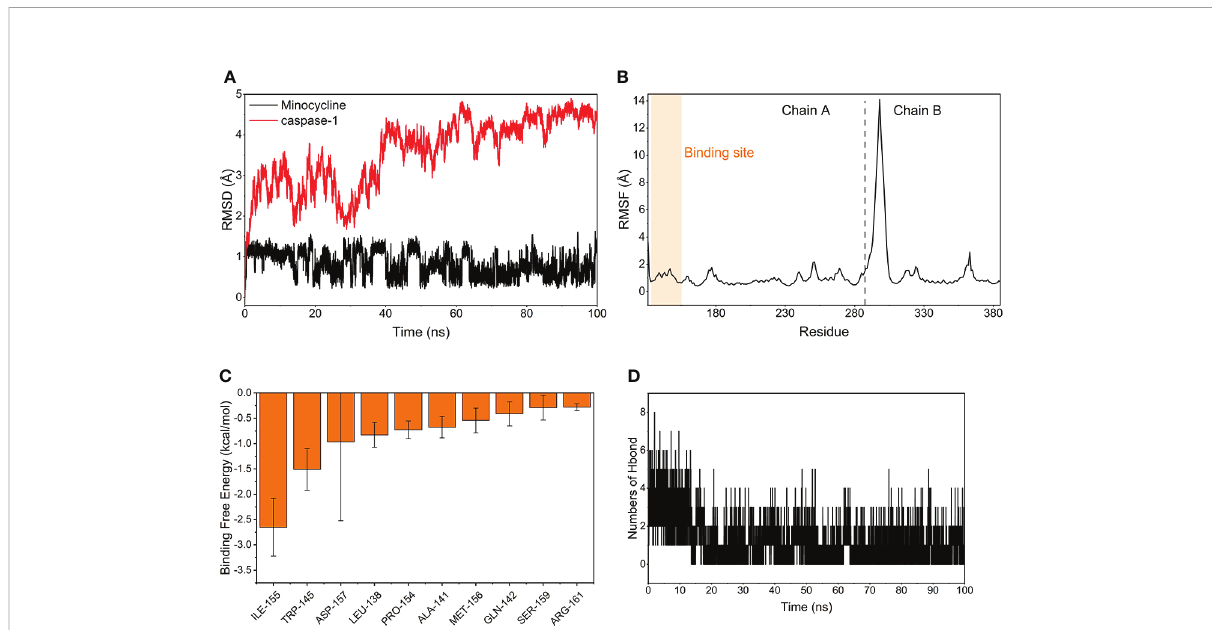
FIGURE 15 Molecular Dynamics Simulation and MM-GBSA. (A) Variation of the root means square deviation (RMSD) difference with time for small molecule compounds (black line) and proteins (red line) during molecular dynamics simulations. (B) Root mean square fl uctuations (RMSF) are calculated based on molecular dynamics simulation trajectories. (C) The top 10 amino acids that contribute to small molecule and protein binding. (D) Changes in the number of hydrogen bonds between small molecules and proteins result from molecular dynamics